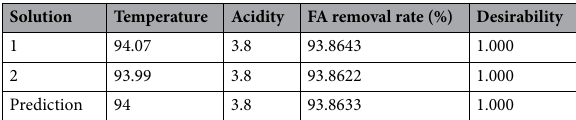
Table 7. RSM system optimized solution.